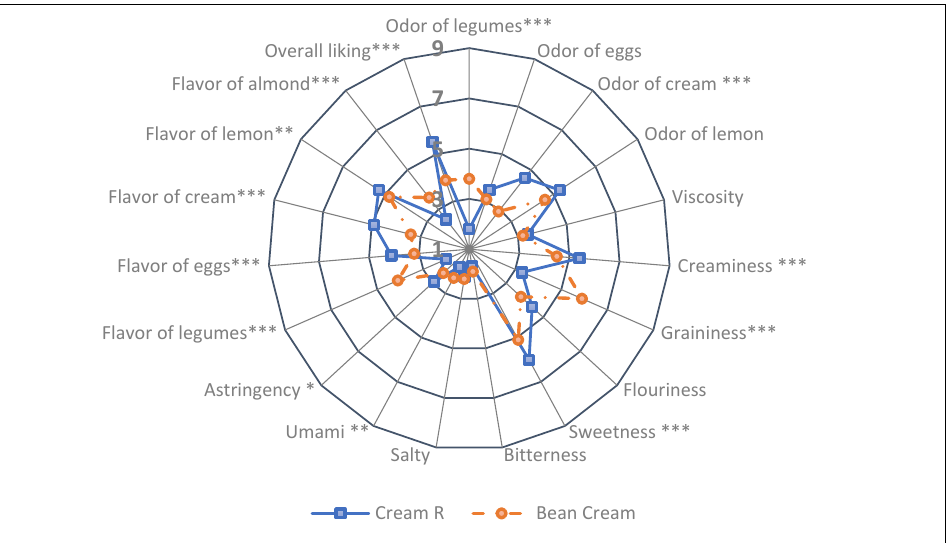
Figure 10. Sensorial profile of cream without (Cream R, reference) and with common bean flour (Bean Cream). Data analyzed by ANOVA and post hoc test (Tukey’s HSD; *, **, *** indicate significant differences between the tested products at p < 0.1, p < 0.5 and p < 0.01, respectively.